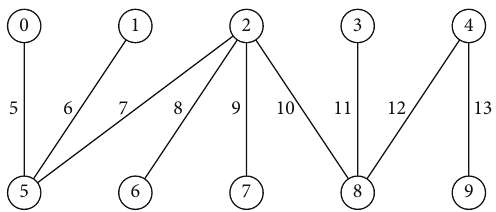
Figure 1: Strongly 5 -harmonious labeling of the caterpillar Cat 10 .